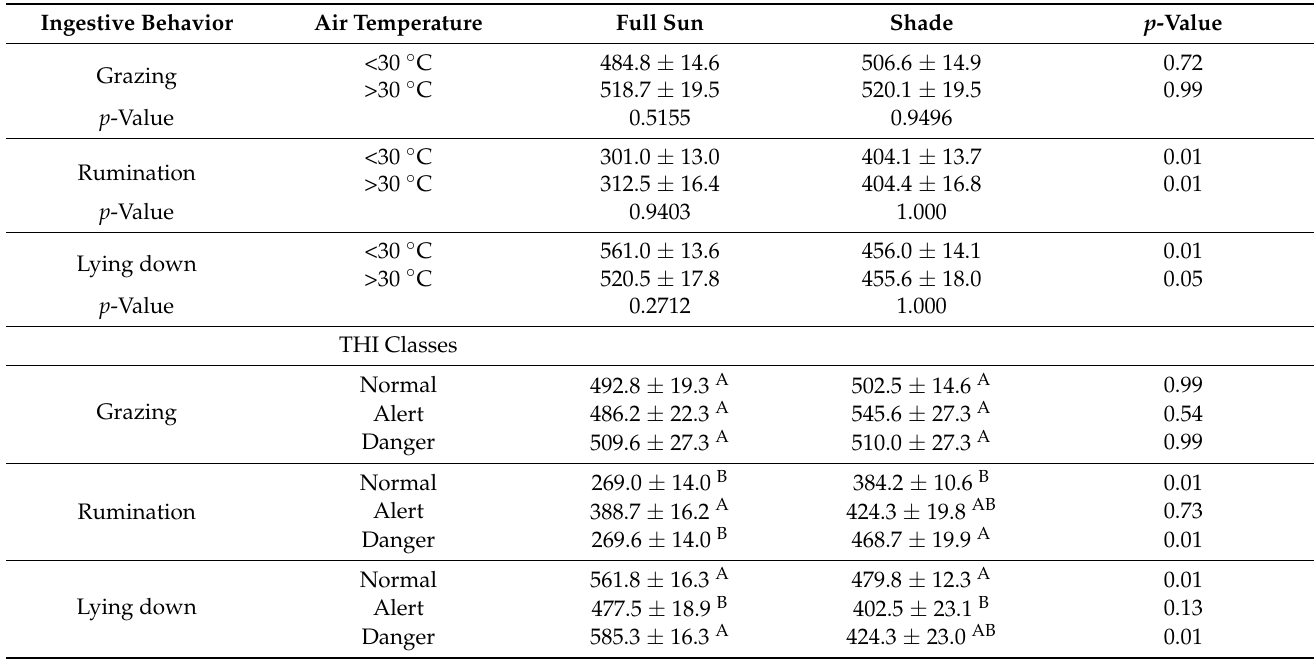
Table 5. Mean time, in minutes, of ingestive behavior during 24 h, of dairy cows under full sun and shade ICLF and under different categories of air temperature and